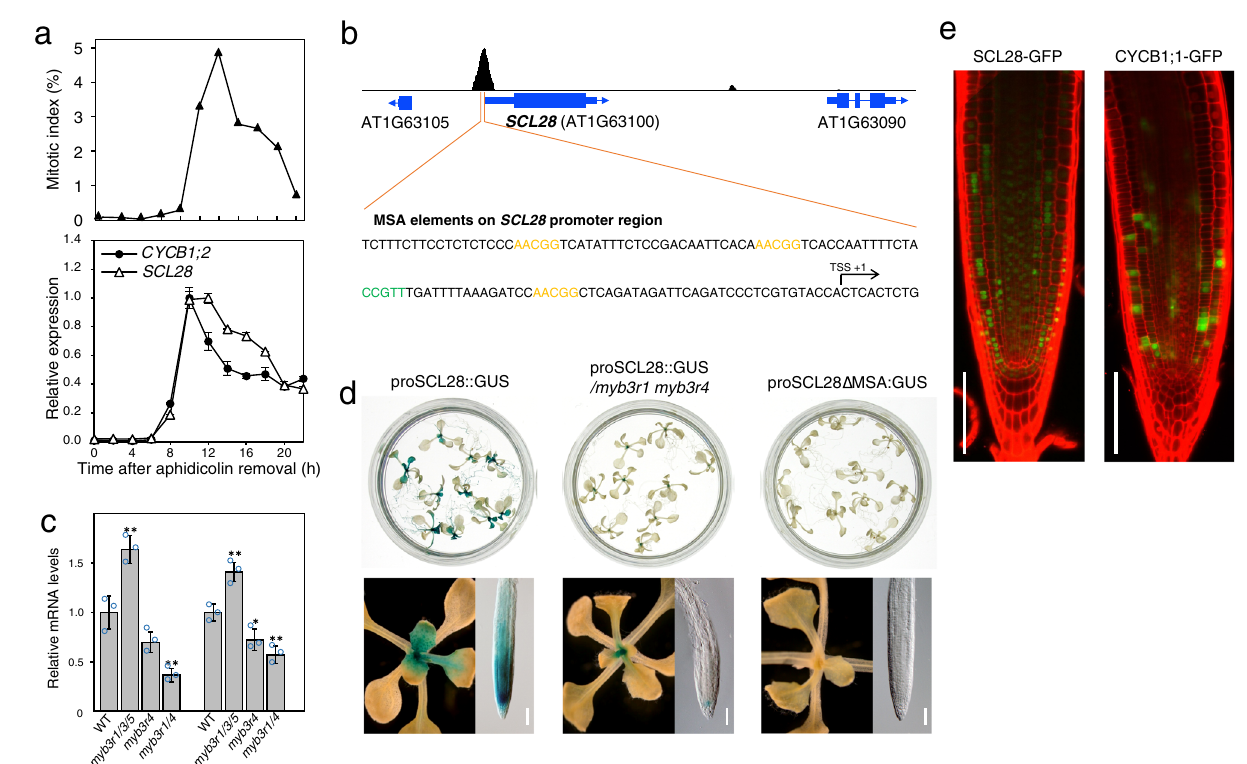
Fig. 1 SCL28 expression is cell cycle-regulated under the control of MYB3R transcription factors. a G2/M-speci fi c accumulation of SCL28 transcript. Arabidopsis MM2d cells were synchronized by aphidicolin treatment and used for qRT-PCR analysis to quantify SCL28 mRNA levels (lower). Synchronous progression of cell cycle was monitored by measuring mitotic index (upper). As a representative of G2/M-speci fi c genes, CYCB1;2 was also analyzed in the same way for comparison. Expression data are shown as averages from three technical replicates (±SD). b MYB3R3 binds to the upstream region of SCL28 . The ChIP-Seq pro fi le of MYB3R3 indicates its direct binding to the proximal promoter region of SCL28 . The nucleotide sequence around the ChIP-Seq peak contains MSA elements repeated four times, of which core motifs (AACGG) are shown by orange (forward orientation) and green (reverse orientation) letters. c Levels of SCL28 transcripts are signi fi cantly affected by mutations in myb3r genes. Transcript levels of SCL28 and KNOLLE were analyzed by qRT- PCR in plants 12 days after sowing (DAS) that carry mutations of myb3r genes in the indicated combinations. Expression data were normalized to ACT2 and shown as averages from three biological replicates (±SD). Statistical signi fi cance was determined using two-sided Student ’ s t test. * P < 0.05, ** P < 0.01. d Promoter activity of SCL28 requires the presence of MYB3R activators and MSA elements. GUS reporter expression was analyzed in wild type (WT) and myb3r1/4 plants carrying proSCL28::GUS and WT plants carrying proSCL28 Δ MSA::GUS, in which all MSA elements in the SCL28 promoter were mutated. GUS staining around shoot apex and root tip regions is shown at higher magni fi cation in the lower panels. Multiple independent lines for each construct showed similar difference in GUS staining. Scale bar indicates 100 µ m. e Patchy pattern expression of SCL28-GFP protein. Root meristems of proSCL28::SCL28-GFP and proCYCB1;1::CYCB1;1-GFP plants were analyzed by confocal laser scanning microscopy (CLSM) after counterstaining of the cell wall with propidium iodide (PI). Green and red signals indicate fl uorescence of GFP and PI, respectively. Similar expression patterns of SCL28-GFP were con fi rmed in multiple independent lines. Scale bar indicates 100 µ